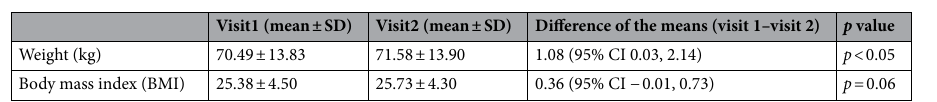
Table 3. Weight and BMI variation (N =